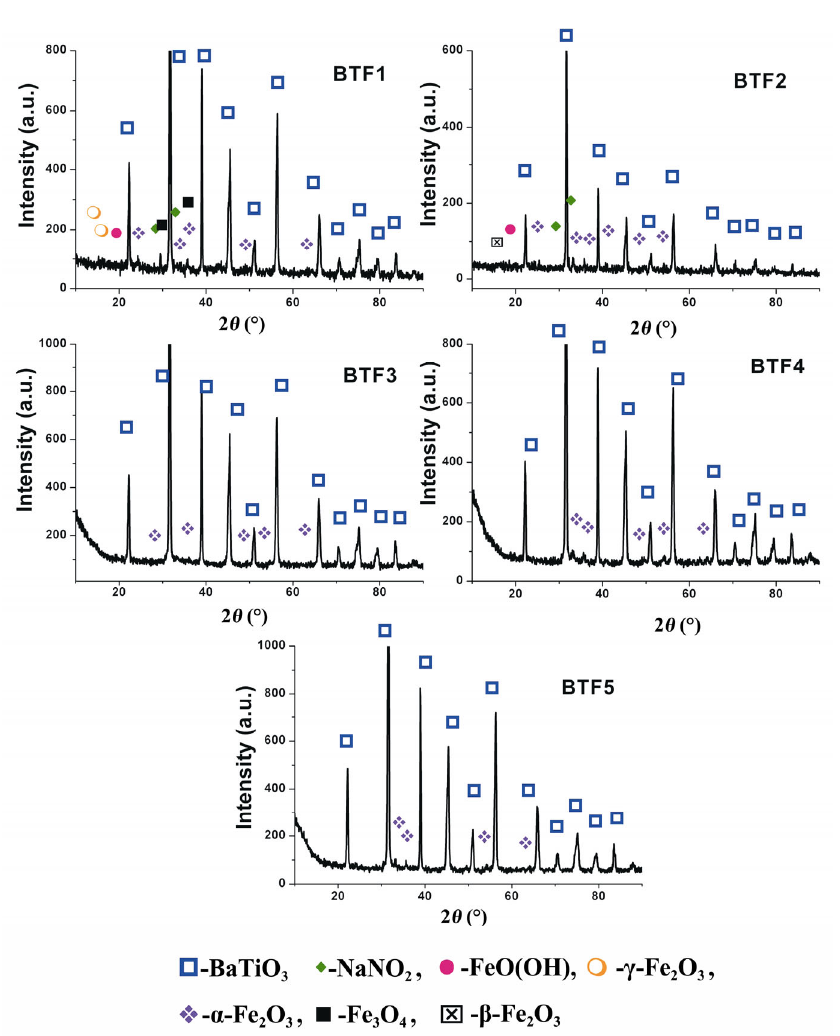
Fig. 1 XRD patterns of the samples BTF1–BTF5 measured at room